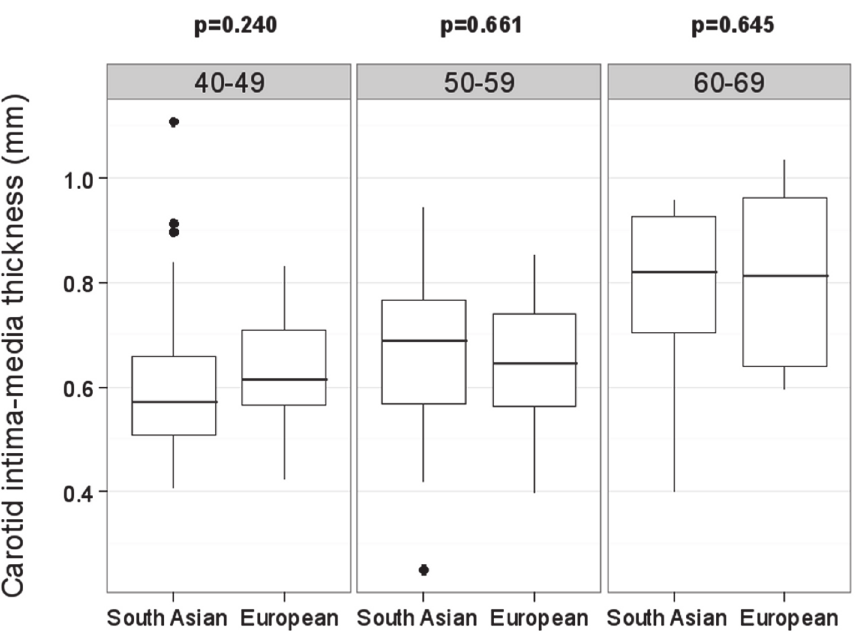
Fig 1. Carotid intima media thickness by age decade and ethnicity. Number of participants in each age decade (South Asian, European): 40 – 49 (55, 55); 50 – 59 (34, 36); 60 – 69 (11,